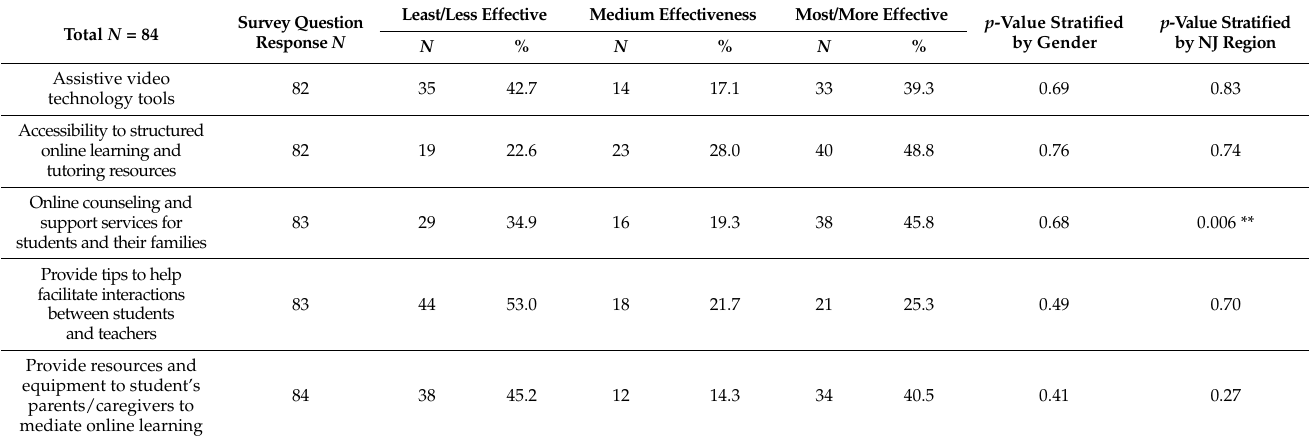
p -ValueStratified by Gender byNJRegion N % N % N